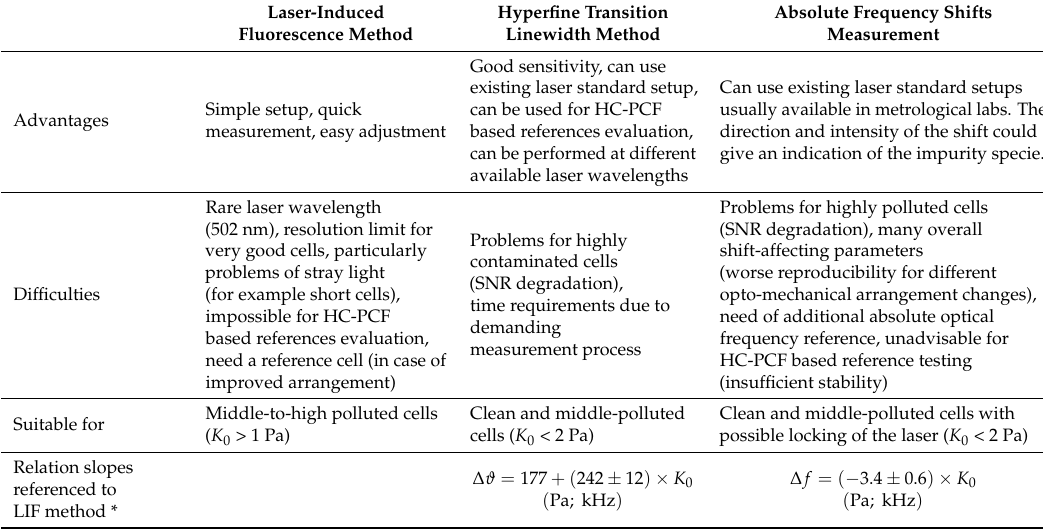
Recommendations of the laser-induced fluorescence, hyperfine transition linewidth measurement and absolute frequency shifts measurement methods for the evaluation of iodine absorption cells’ purity. The relationships between the methods are valid for R(56) (32-0), a 10 iodine hyperfine transition